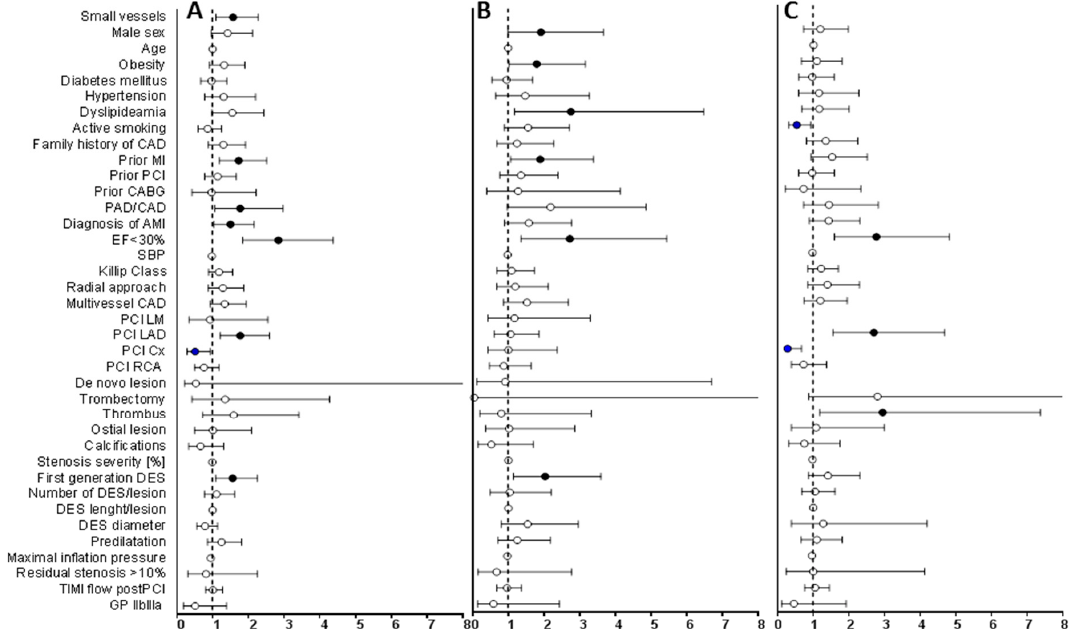
Figure 2. Univariate Cox proportional hazard model for long-term major adverse cardiac and cerebrovascular events (MACCEs) in all patients ( A ), large vessels ( B ), small vessels ( C ). Data are presented as HR and 95% CI. Full dots represent HR of statistically significant risk factors, empty dots represent HR of not statistically significant variables, bars represent 95% CI, dotted line shows HR =